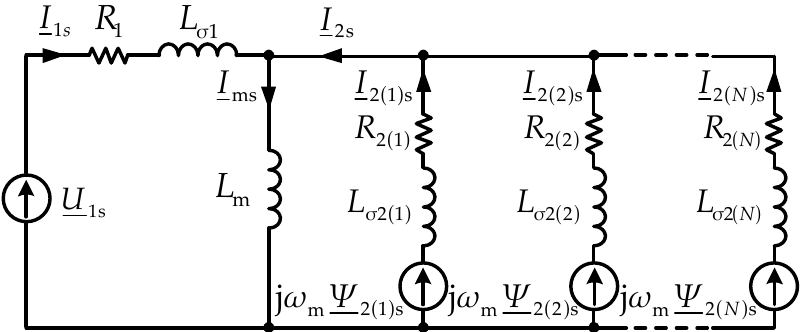
Figure 1. The IM equivalent circuit with the rotor represented by the parallel connected branches consisting of the series rotor equivalent resistance and leakage inductance.